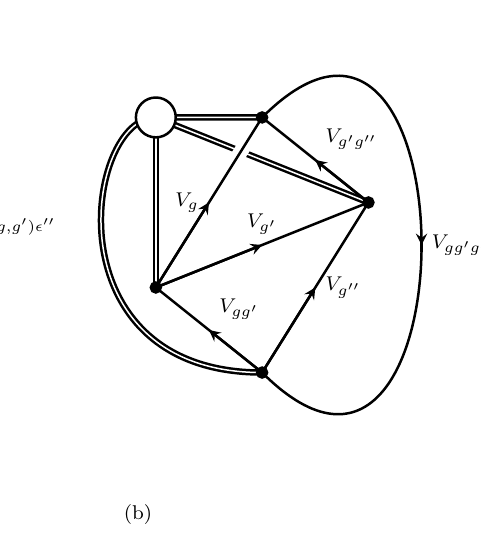
Figure 19 . Gu-Wen fermionic SPT phases: (a) The planar graph dual to the tetrahedron which computes ^ (cid:11) in a gauge determined by the choice of morphism at the junctions. We partial gauge-(cid:12)x as in the previous (cid:12)gure. The resulting web of center lines can be simpli(cid:12)ed by bringing together all planar junctions and collapsing planar loops, up to resolving a single crossing (See next (cid:12)gure 20). Up to the corresponding sign, we obtain: (b) a graph which depends on G elements only and de(cid:12)nes (cid:23) 3 .